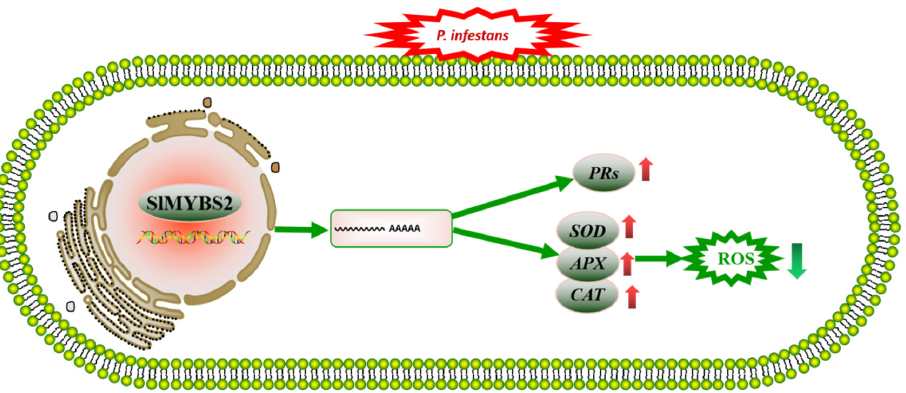
Figure 7. A proposed model for the putative role of SlMYBS2 in the regulation of pathogen defense responses. The green arrows pointing upward represent upregulated genes or functions, while the red arrows pointing downward represent downregulated genes or functions. The green solid lines represent our results.